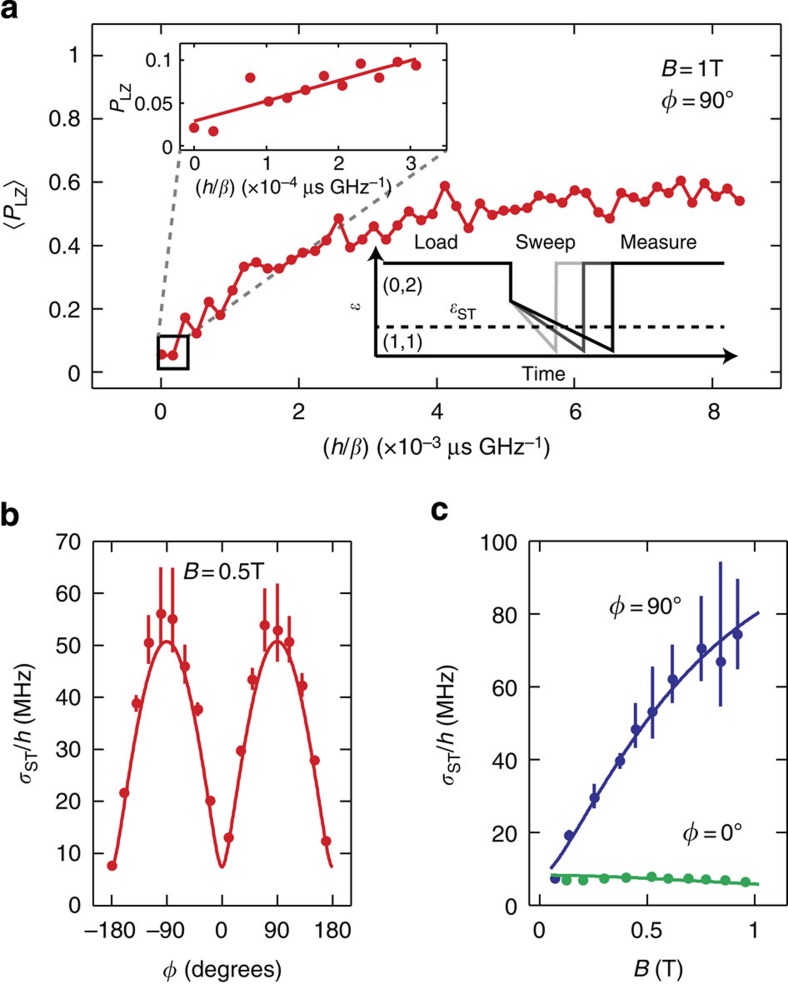
Measurements of σST.(a) Data for a series of LZ sweeps with varying rates, showing reduction in maximum probability due to charge noise. The horizontal axis is proportional to the sweep time. Upper inset: data and linear fit for fast sweeps such that 0<〈PLZ〉<0.1. Lower inset: in a LZ sweep, a |(0,2)S〉 state is prepared, and ɛ is swept through ɛST (dashed line) with varying rates. Here h=2πħ is Planck's constant. (b) σST versus ϕ (dots) and simulation (solid line). (c) σST versus B for ϕ=0° and ϕ=90° (dots) and fits to equation (3) (solid lines). When ϕ=0°, ΔSO is fixed at zero, and the only fit parameter is σHF. When ϕ=90°, σHF is fixed at the fitted value, and ΔSO is the only fit parameter (see Methods section). Error bars are fit errors.